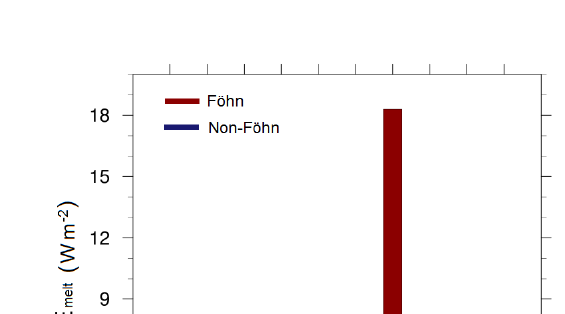
After observation period